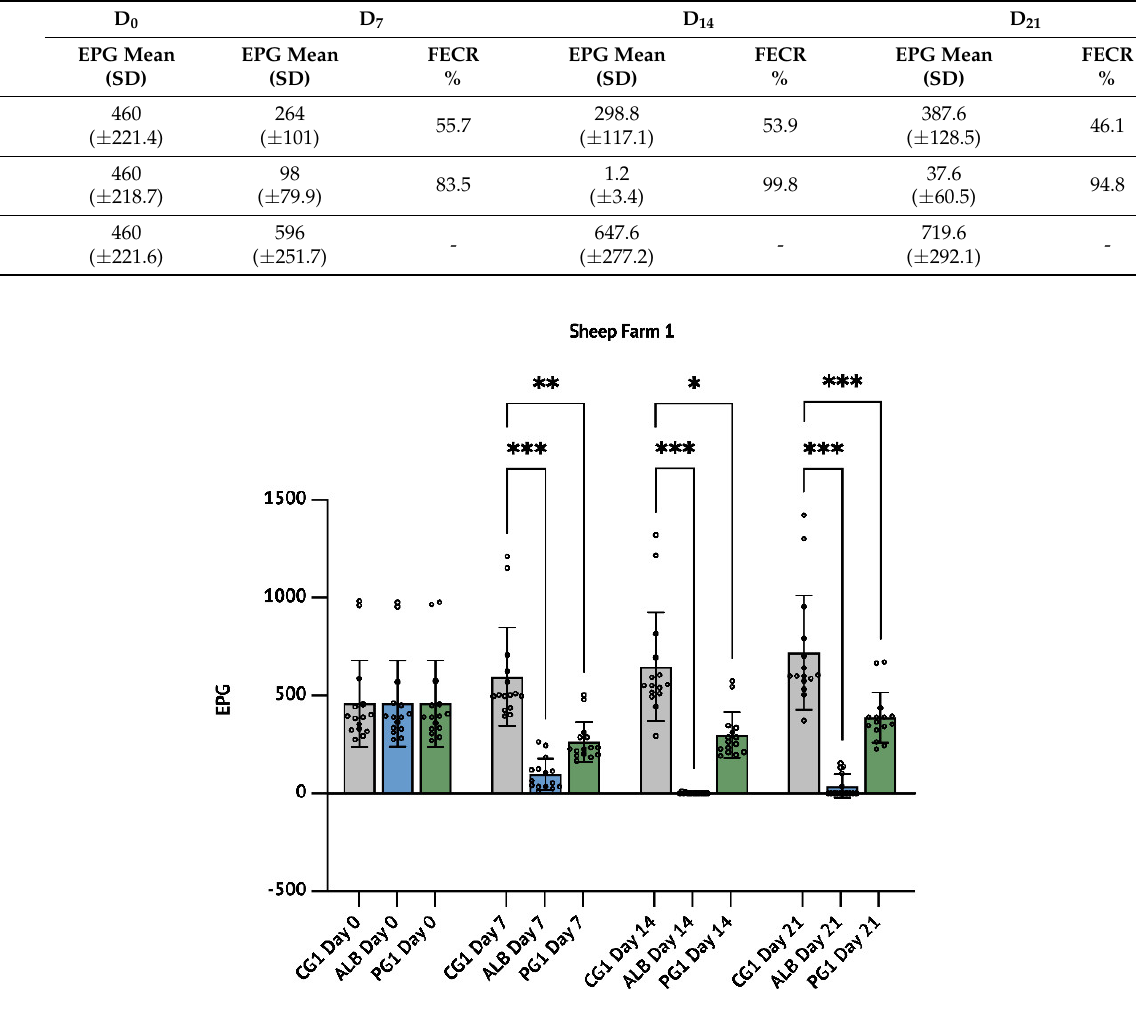
Figure 1. Sheep farm 1 (SF1): results concerning the comparison between the anthelmintic efficacy of the aqueous P. granatum macerate with Albendazole. The results are expressed as mean ± S.D. * p < 0.05, ** p < 0.01, *** p < 0.001.